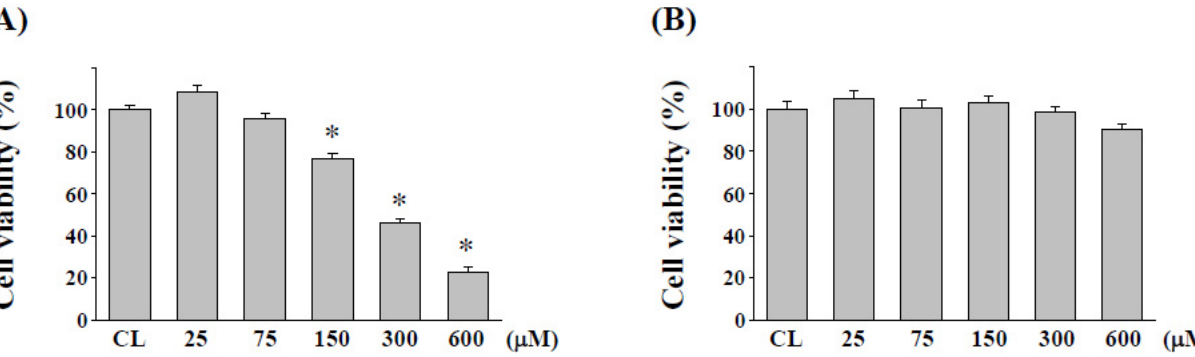
Figure 1. Changes in cytotoxicity of quercetin after fermentation. NCM460 cells were cultured in the presence of ( A ) unfermented quercetin and ( B ) fermented quercetin for 24 h, and cell cytotoxicity was determined by MTS assay. Data represent the mean ± SEM from three independent experiments; * p < 0.05 vs. CL NCM460 cells.